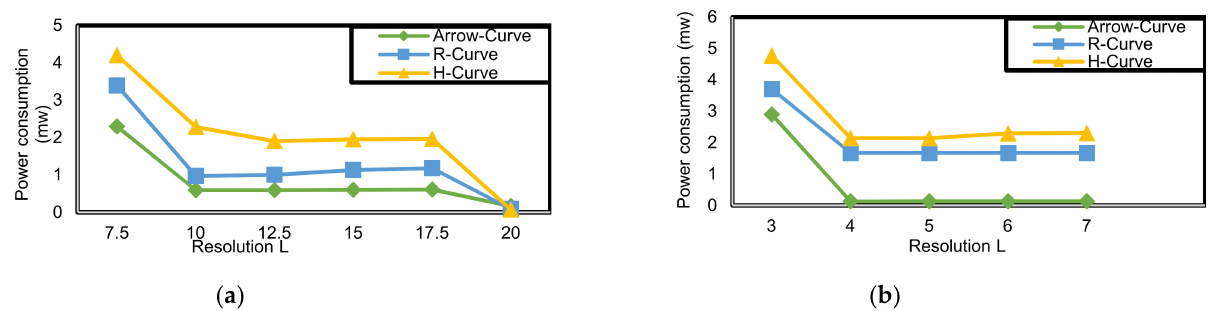
Figure 25. Power consumption (mW) corresponding to resolution (L) in Arrow-Curve model, R-Curve path model, and H-Curve: ( a ) outdoor environment; ( b ) indoor environment.